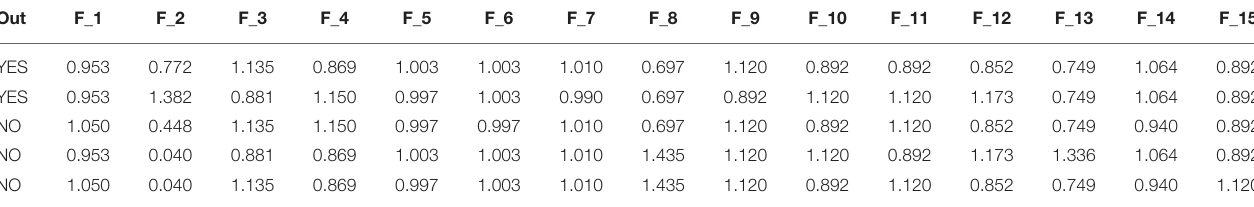
TABLE 3 | Lung cancer scaled dataset sample.